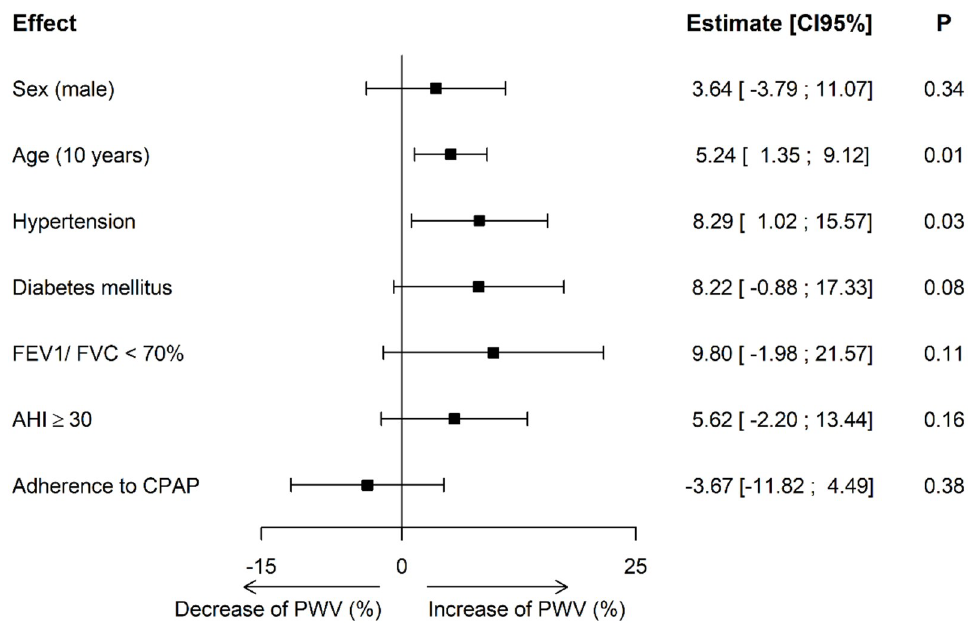
Fig 3. Multivariate analysis. FEV1, Forced Expiratory Volume of the first second of forced expiration; FVC, Forced Vital Capacity; AHI, apnea hypopnea index; CPAP, continuous positive airway pressure. Interpretation: A 10-year increase in age was associated with a 5.24% increase in PWV. Compared to the baseline PWV value of the multivariate model, this is associated to a significant increase of 0.35m/s of PWV for 10-year age increase. Having hypertension at baseline was associated to a significant increase in PWV of